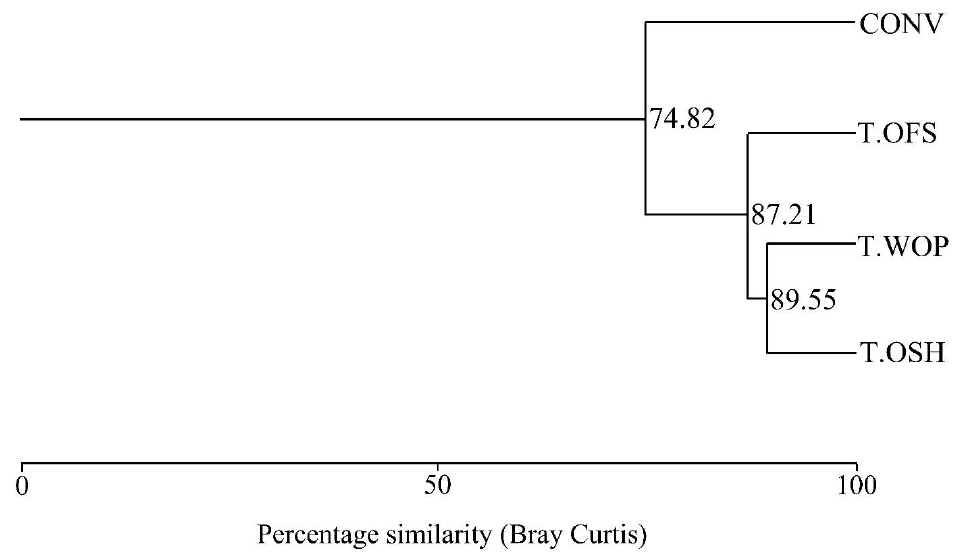
Figure 1. Diagram of the cluster analysis (Bray–Curtis index) indicating the similarities between the four coffee ( Coffea arabica ) production systems, namely, conventional (CONV) and transition to organic shaded (T.OSH), organic full-sun (T.OFS), and without pesticide (T.WOP). February 2013 to December 2014. Campo do Meio and Guapé, MG, Brazil.